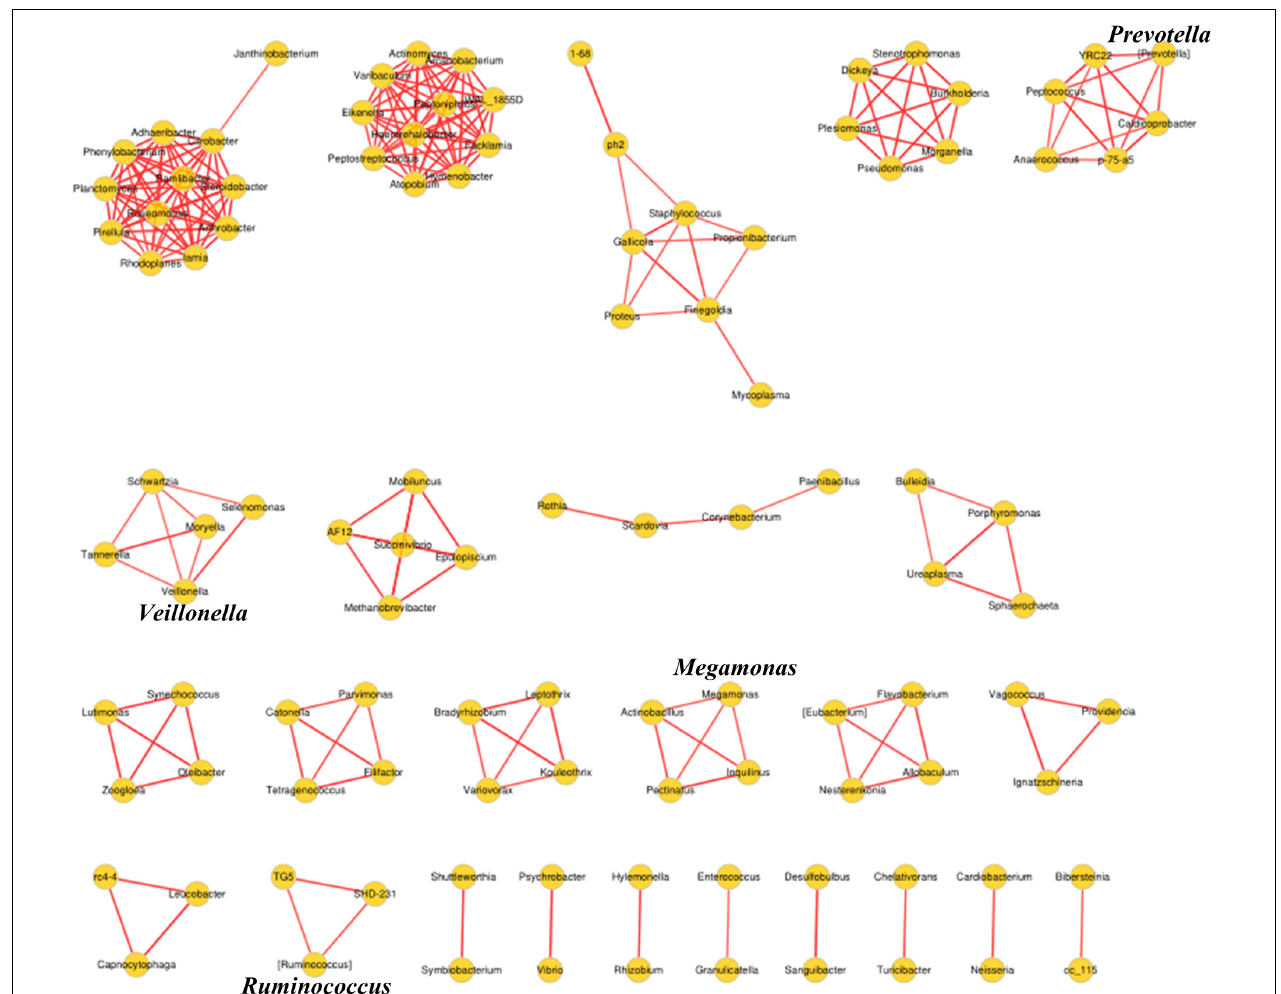
FIGURE 7 | Association network diagram of bacterial genera among CRC patients from all the clinical groups. Network analysis conducted by spearman correlation ( R > 0.8, P < 0.05, Red line, positive correlation) is